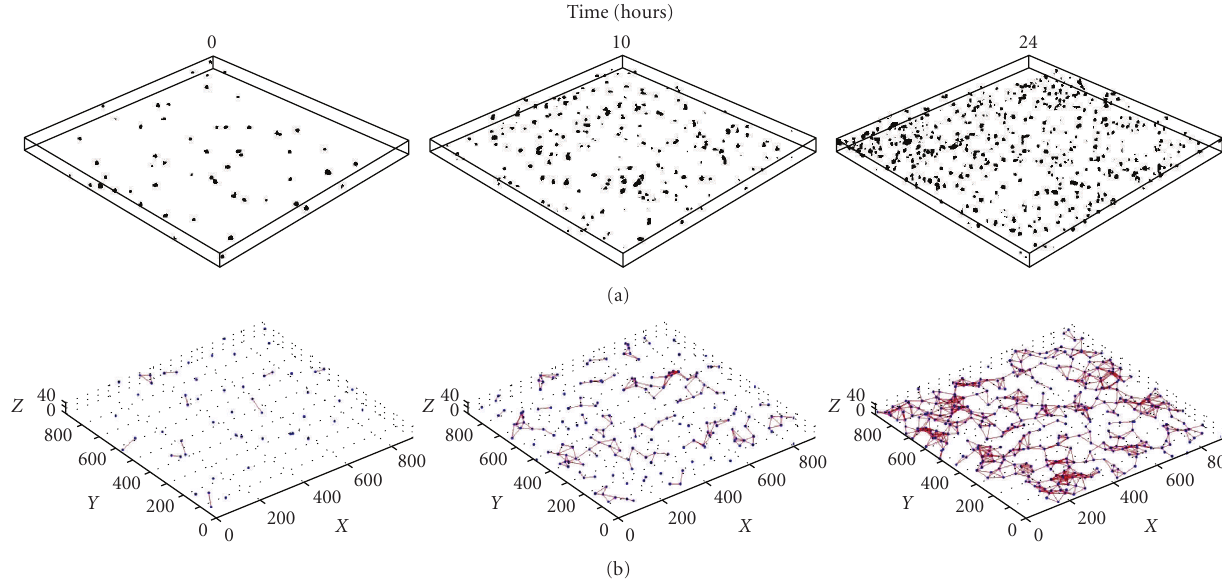
Figure 2: Graph theory applied to fluorescent confocal z-stack images to generate distance dependent cell-graphs for 3.0 × 10 5 cell/mL gels. (a) 3D representation of fluorescent image z-stack. (b) 3D cell-graph generated from fluorescent image z-stack.